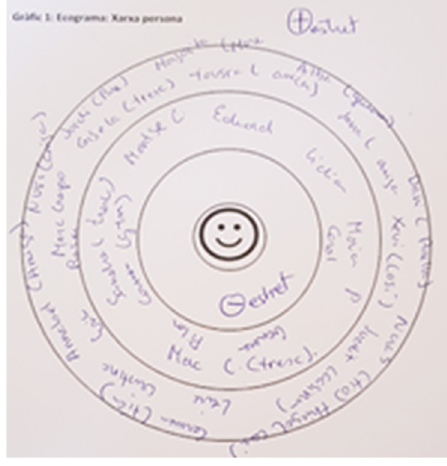
Figure 1. Ecogram (alters names).